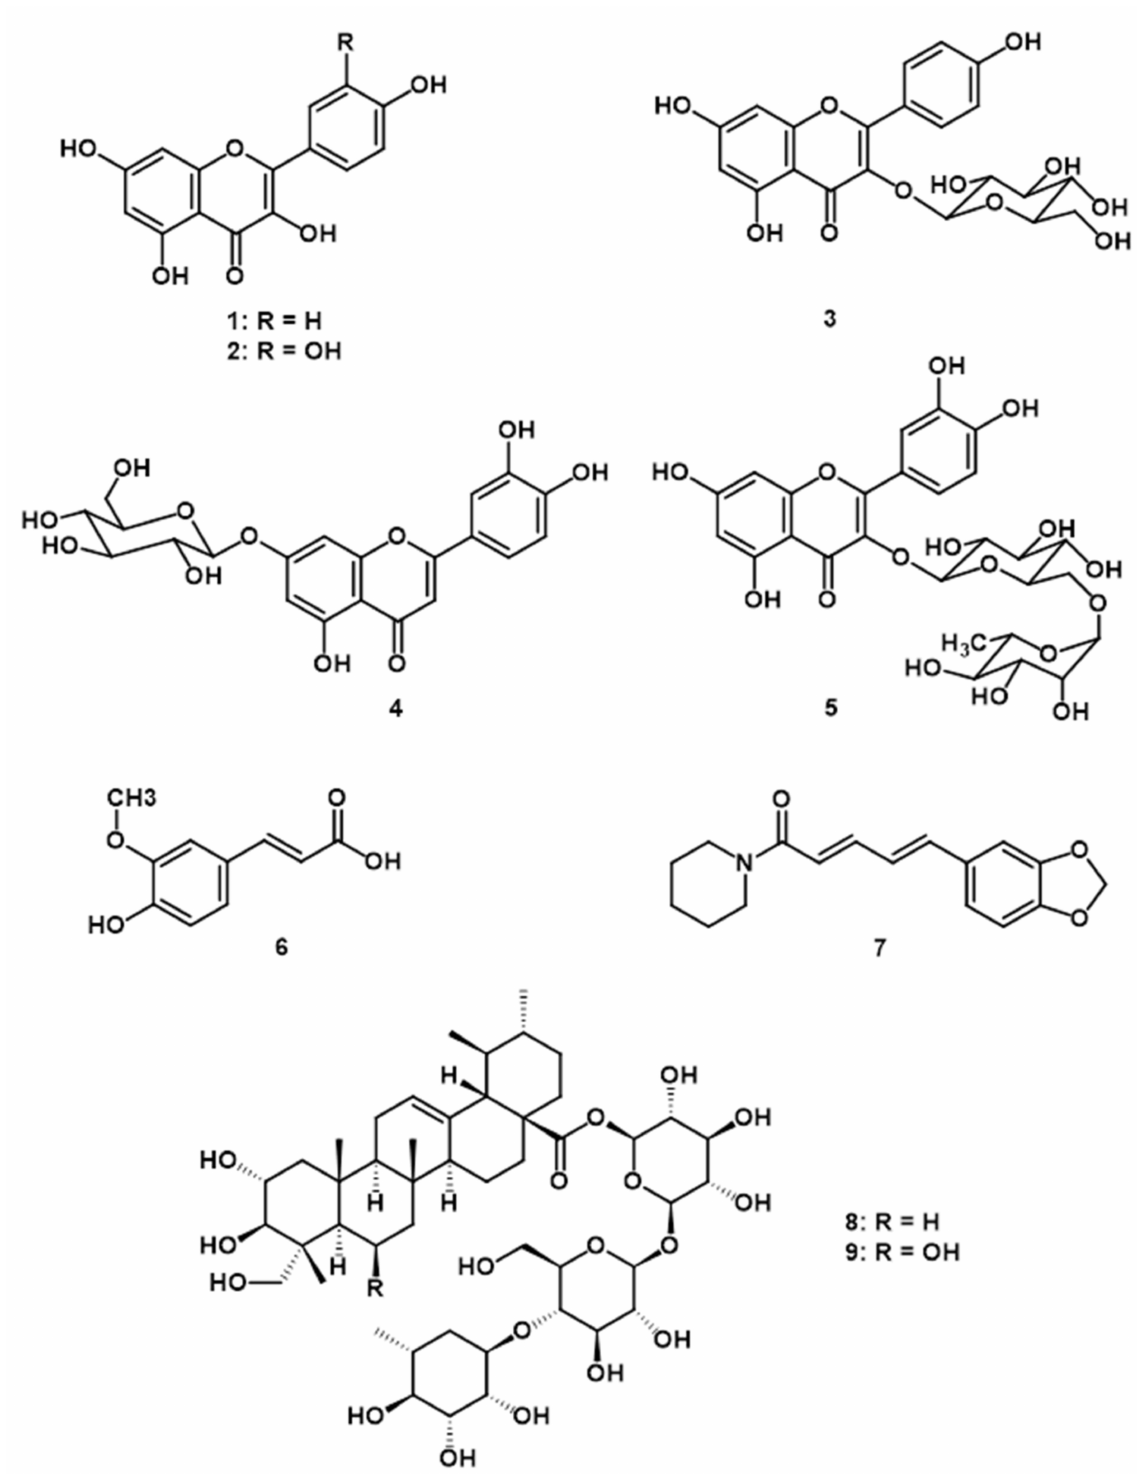
Figure 5. Structures of kaempferol ( 1 ), quercetin ( 2 ), kaempferol-3-glucoside ( 3 ), luteolin-7- O -glucoside ( 4 ), rutin ( 5 ), ferulic acid ( 6 ), piperine ( 7 ), asiaticoside ( 8 ), and madecassoside ( 9 )